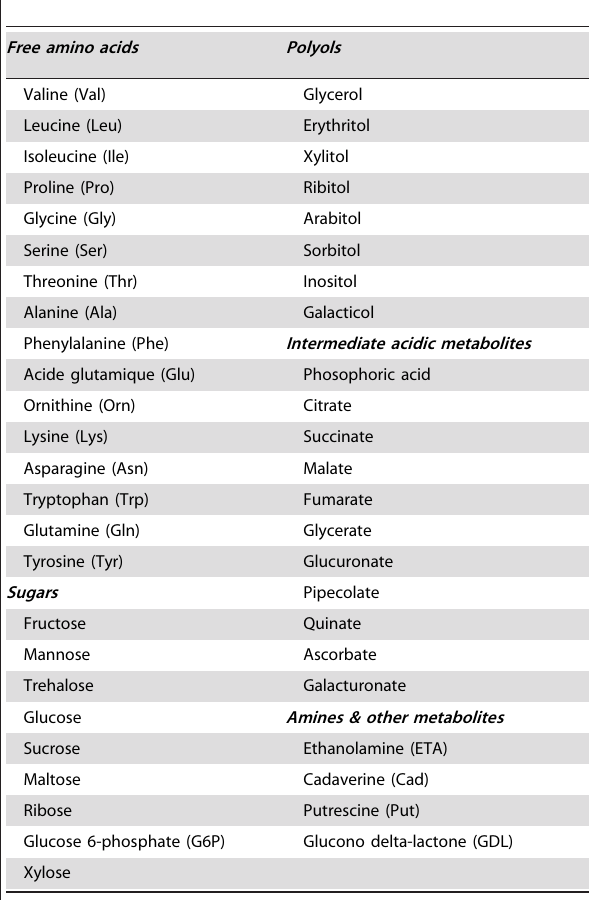
Table 1. Metabolites detected in the mummified parasitoids P. volucre i